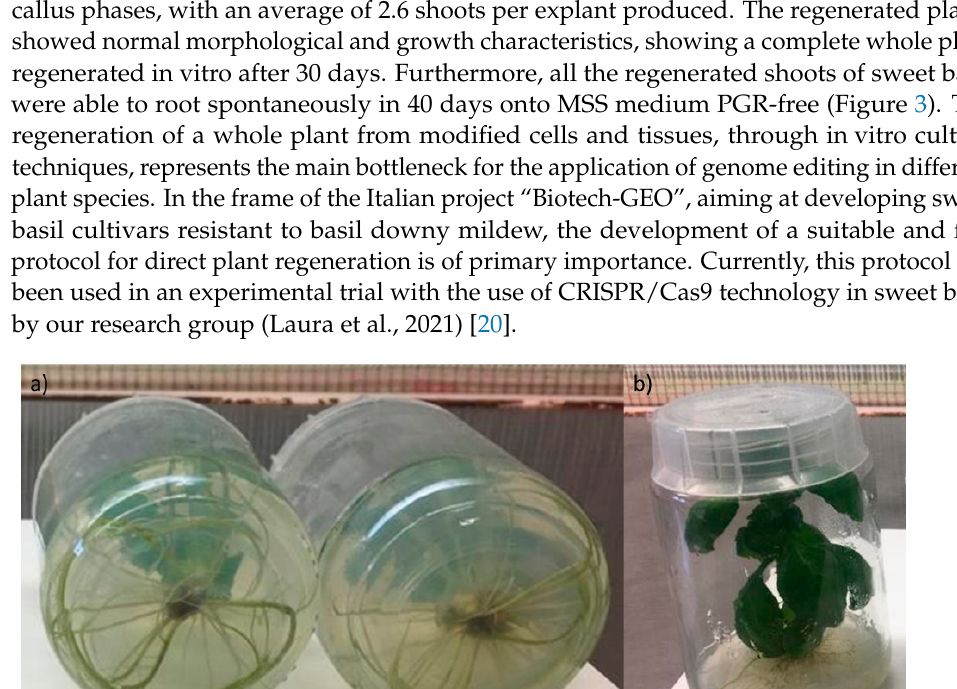
Table 2. Shoot regeneration (%) and mean n. of shoots per responsive explants: maximum score recorded among the experiments related to different explant types. Data are presented as mean ± SE.